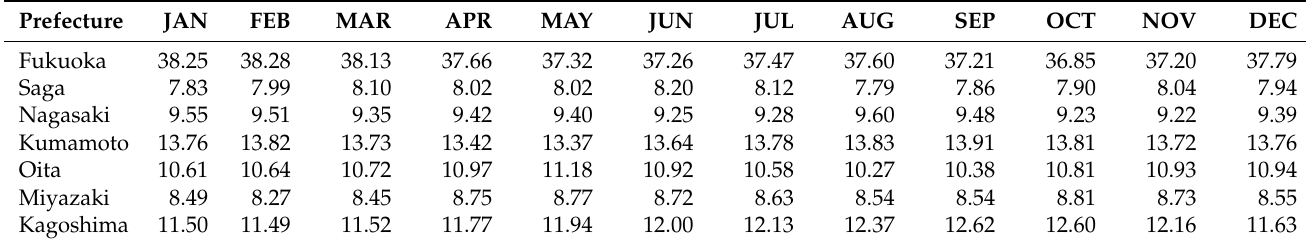
Table 3. Average monthly demand share (%) in Kyushu from 2016 to 2019.